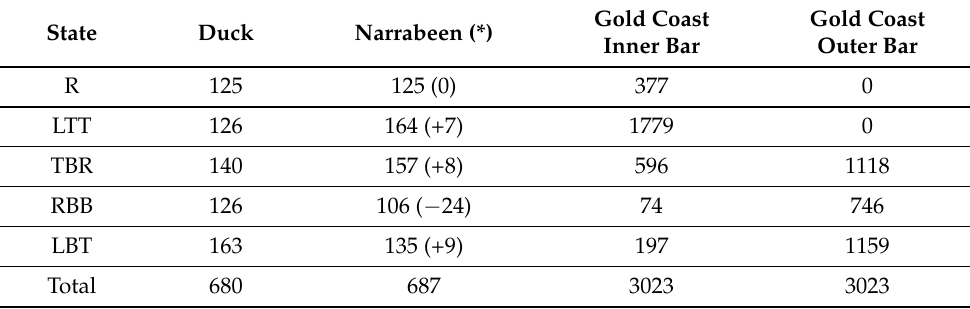
Table 1. Per state data distribution for Duck, Narrabeen and the Gold Coast’s inner and outer bar (* Differences with [36] after adjusting labels). Gold Coast Gold Coast State Duck Narrabeen (*) Inner Bar Outer Bar R 125 125 (0) 377 0 LTT 126 164 (+7) 1779 0 TBR 140 157 (+8) 596 1118 RBB 126 106 ( − 24) 74 746 LBT 163 135 (+9) 197 1159 Total 680 687 3023